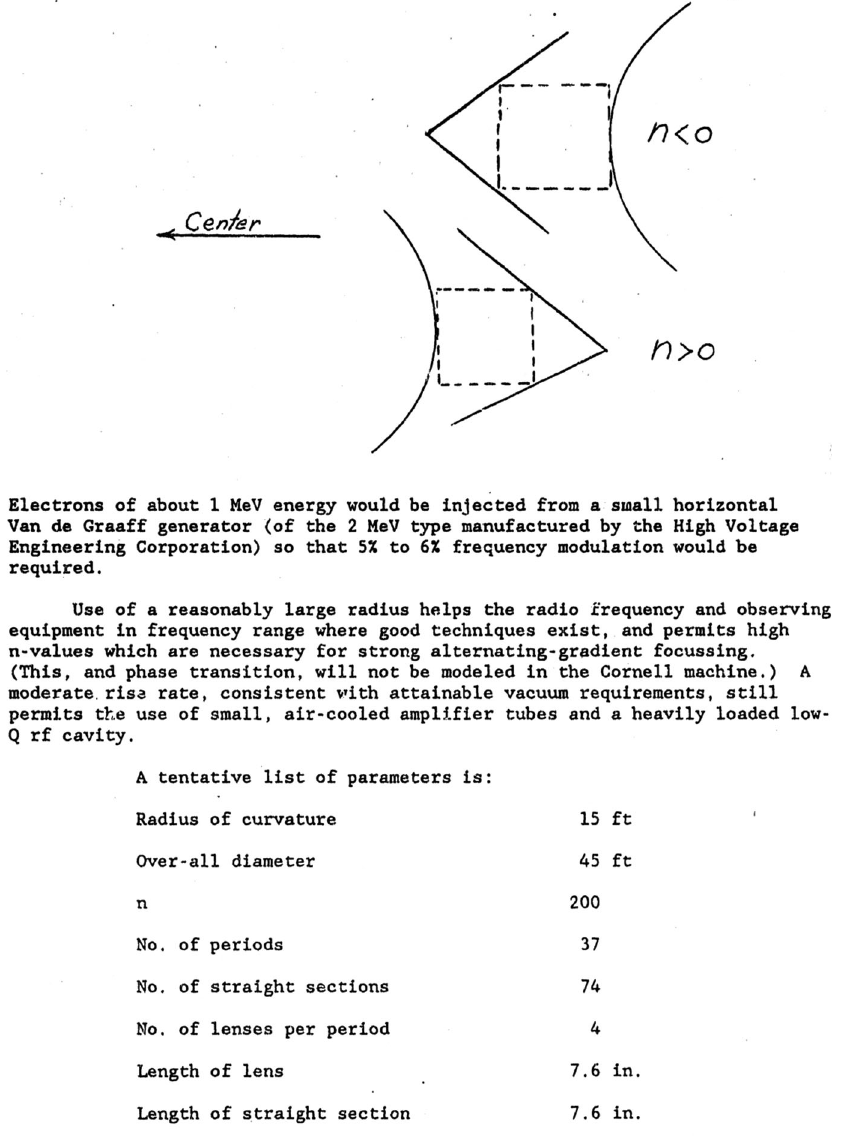
FIG. 9. Haworth letter, page